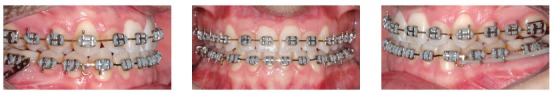
Intraoral photographs after anterior crossbite correction.